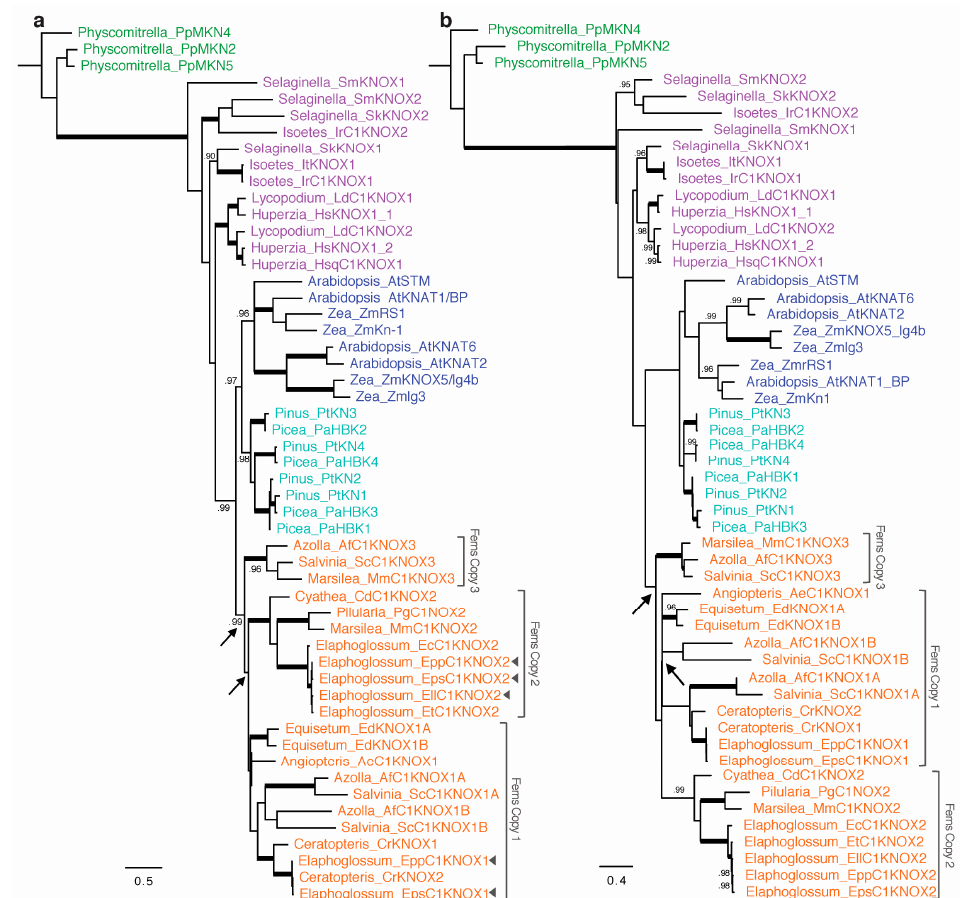
Figure 2. Phylogeny and evolution of Class I KNOX genes in ferns. ( a , b ) Phylograms inferred with ( a ) nucleotides and ( b ) amino acids presented as majority-rule consensus trees recovered in Bayesian inference (BI) analysis, including branch lengths and posterior probability (PP) values for nodes. Thick branches indicate PP = 1. PP values below 0.90 are not displayed. Colors of clade names correspond to the sources of the genes: green, bryophytes; purple, lycophytes; orange, ferns; light blue, gymnosperms; dark blue, angiosperms. Species abbreviations are listed in Appendix A. Arrowheads in ( a ), genes used for in situ hybridization analyses; arrows, inferred duplications within ferns.